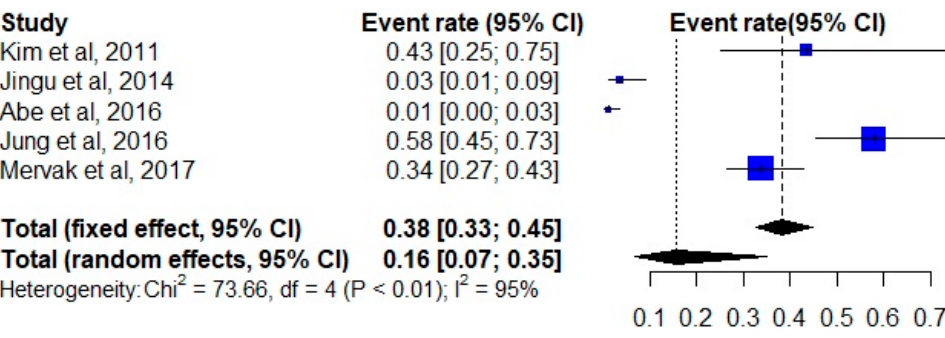
Figure 2. Forest plot of the initial event rate of hypersensitivity reactions in all included studies. [29,26,30,28,27].